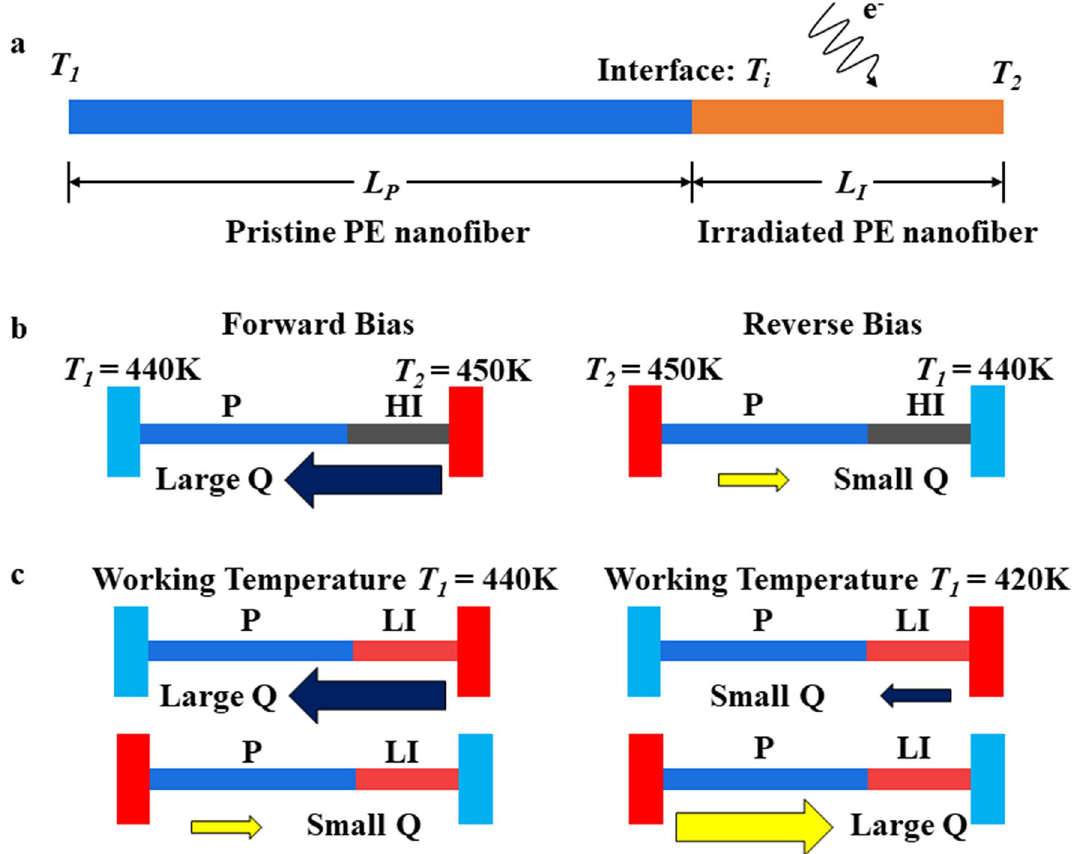
Figure 2. ( a ) Physical model of the ‘irradiate-pristine’ PE nanofiber junction in the forward bias. ( b ) Schematics of the rectification behaviors of the HI-P junction. ( c ) Schematics of the dual-directional rectification of the LI-P